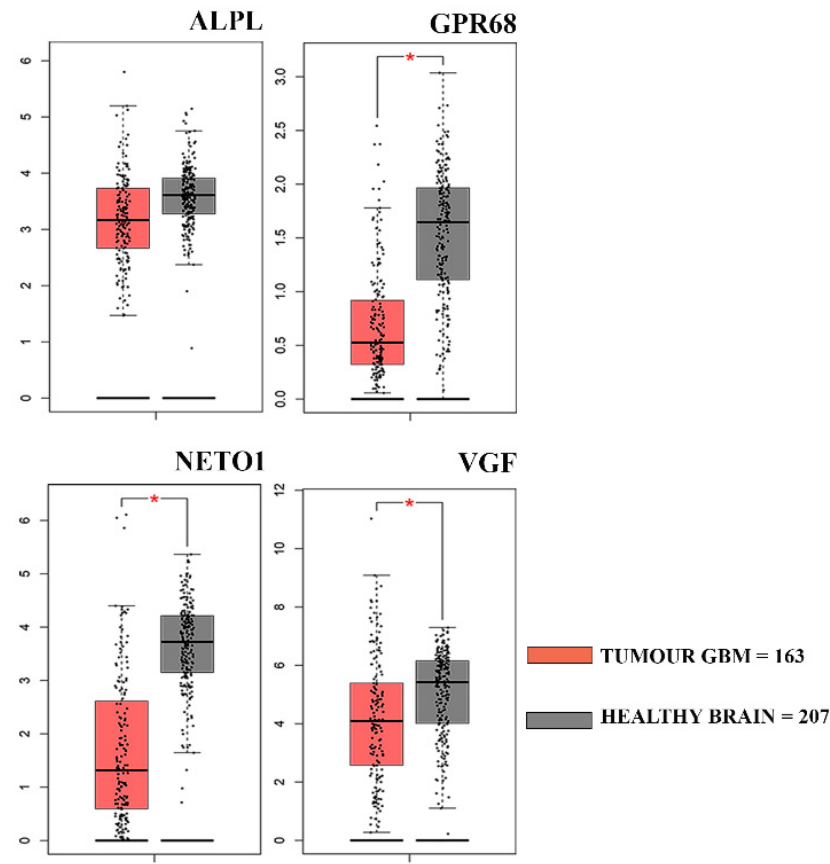
Figure 2. Gene expression profiling of the four genes down-regulated in GASC-LS in the TCGA- GBM RNA-seq dataset. Box plots represent the gene expression levels in the TCGA-GBM dataset (n = 163) and in the TCGA-GTEx matched normal samples (n = 207) of the genes with a significant down-regulation in GASC-LS, identified with the RT2 Profiler array. Data were obtained and plotted from the GEPIA web server (|Log2FC| Cutoff: 1; * p -value < 0.01).